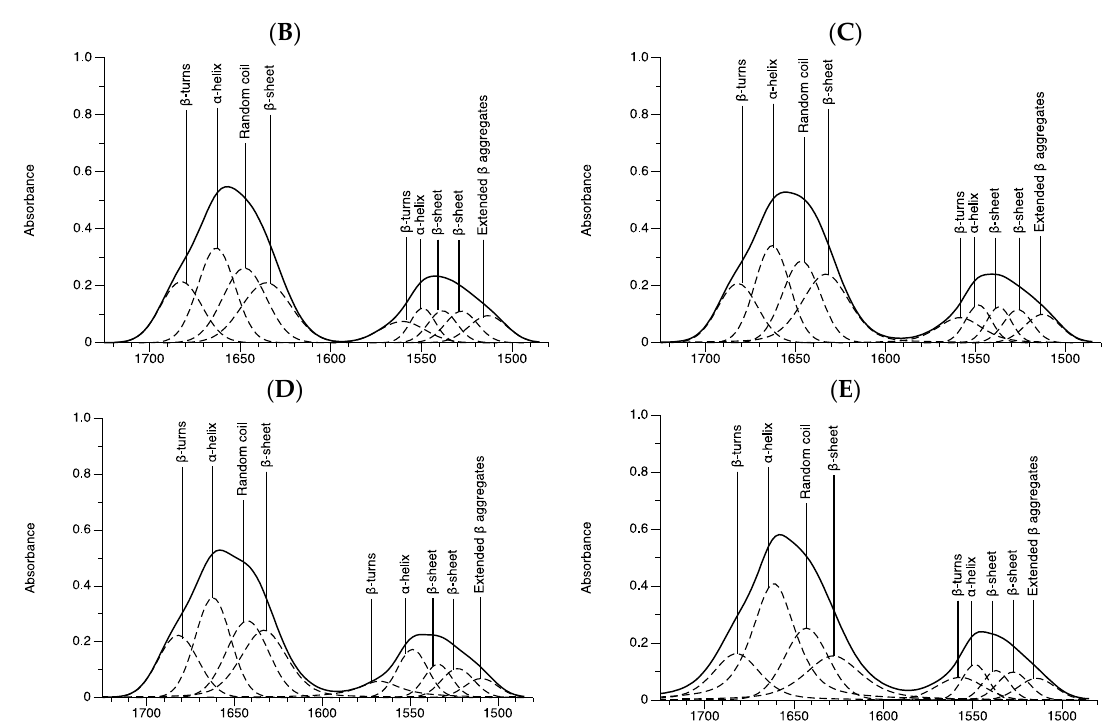
Figure 8. Average absorbance of amide I and II bands contour with best-fit 50% Lorentzian / Gaussian individual component bands for ( A ) 2D cells (RMS error is 0.003), ( B ) 5000 (RMS error = 0.004), ( C ) 8000 (RMS error = 0.004), ( D ) 10,000 (RMS error = 0.006), and ( E ) 20,000 (RMS error = 0.004) spheroid cells .